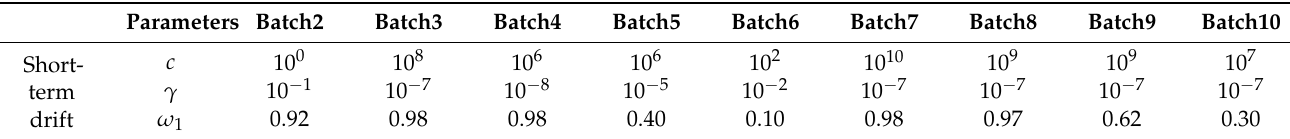
Table 5. Short-term drift parameter